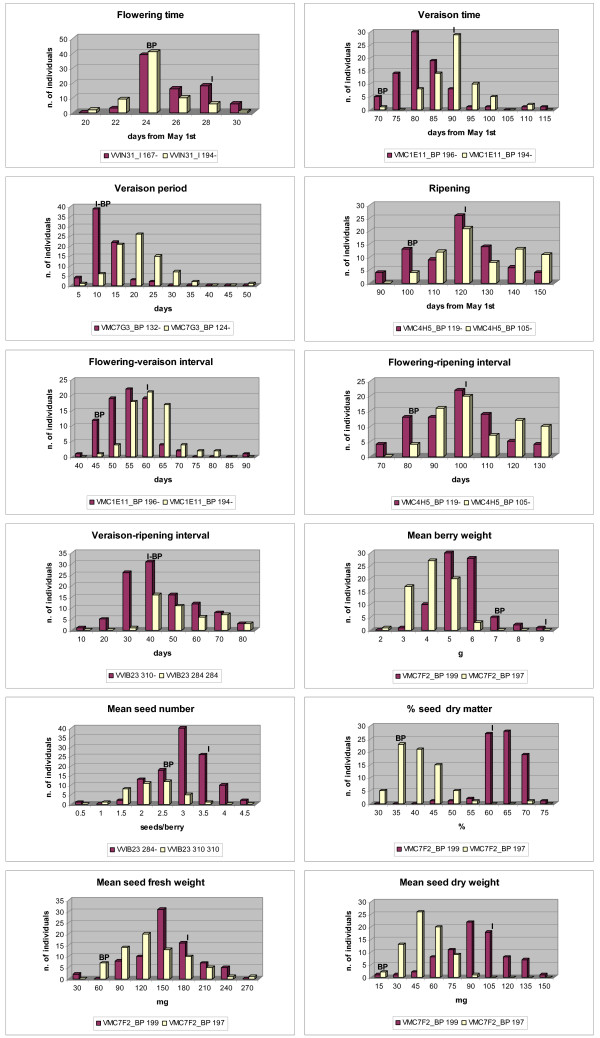
Distribution of phenotypic traits in 2003. The microsatellite marker explaining the highest proportion of variability for each trait (Table 5) was used as dividing criterium to identify two subpopulations with different alleles. Allele sizes are reported in the legend (I = Italia, BP = Big Perlon).